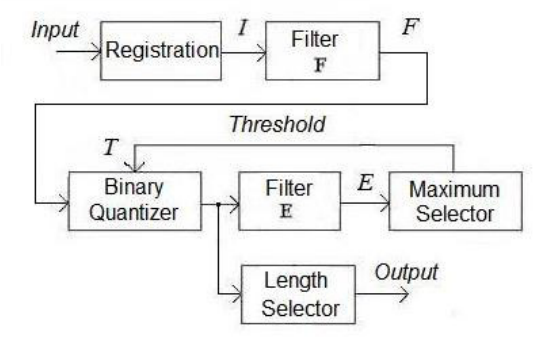
Figure 15. Processing structure with adaptive threshold setting and control Hierarchy of isolated fragments is proposed for analysis of connected fragments. Analysis of small connected fragments is useful for obtaining indicators for threshold setting and control. Extraction efficiency is introduced as the relative number of points in fragments with respect to all points exceeding threshold. The best threshold level should give maximal extraction efficiency for a given size of characterizing Figure 14. Extraction efficiency for isolated points (line 1), fragments with characterizing mask 2x2 (line 2), and mask 3x3 (line 3)